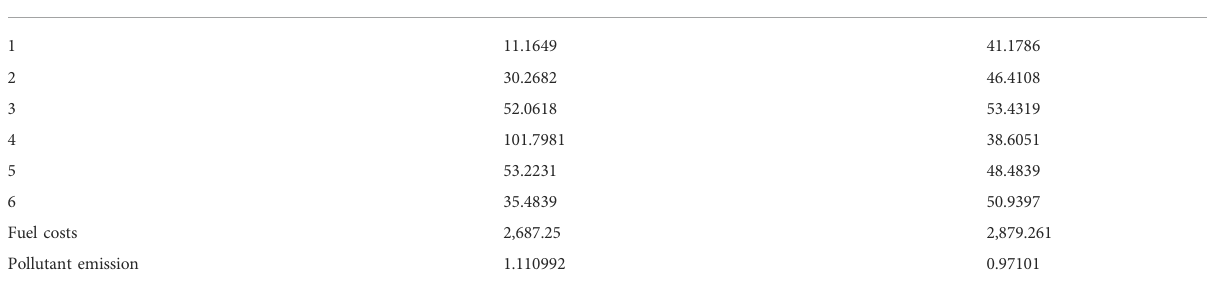
TABLE 3 Boundary solution of